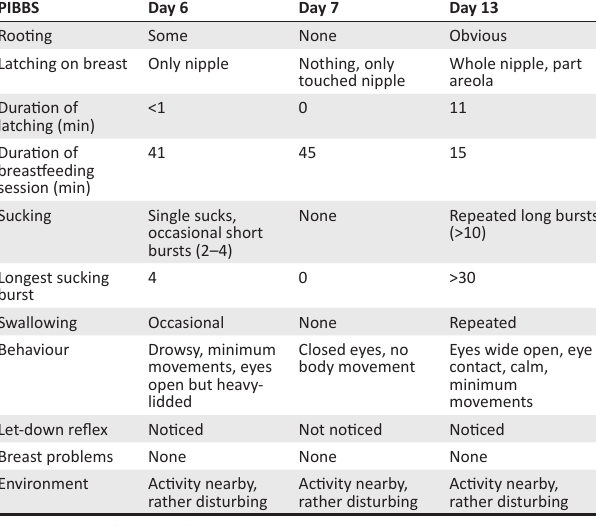
TABLE 2: Breastfeeding results according to the Preterm Infant Breastfeeding Behavior Scale. PIBBS